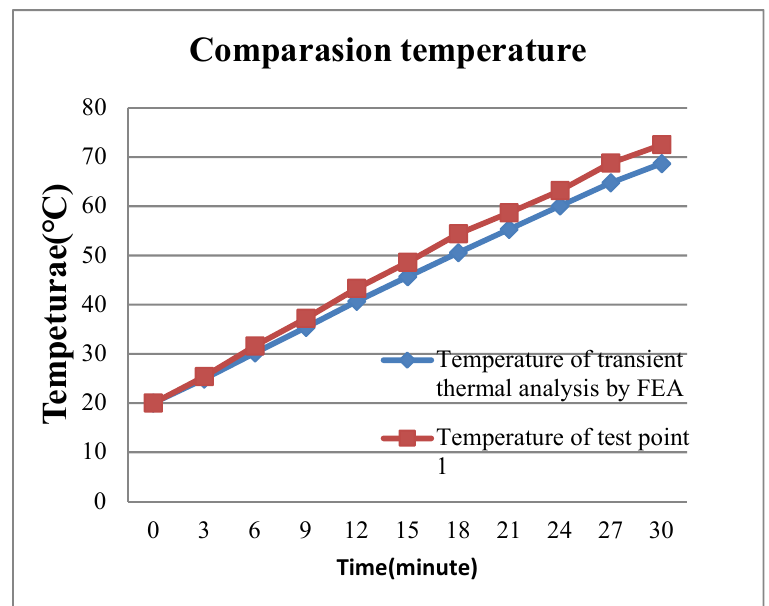
Figure 13. The load test bench of the motor.